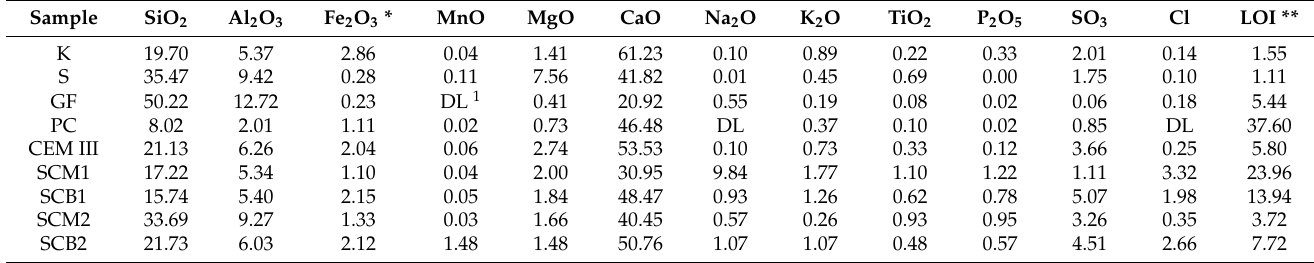
Table 1. Chemical compositions of SCMs and SCBs (wt%), as determined by XRF.